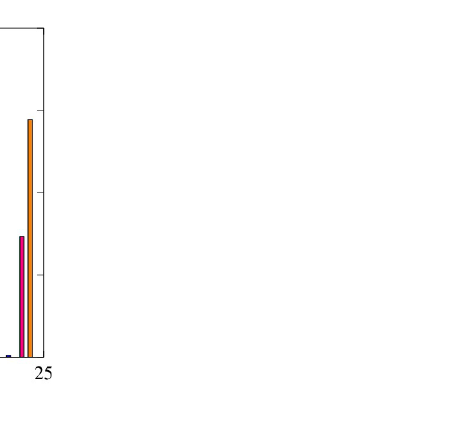
Fig 7. The average discharging power of BESS in Case 4.